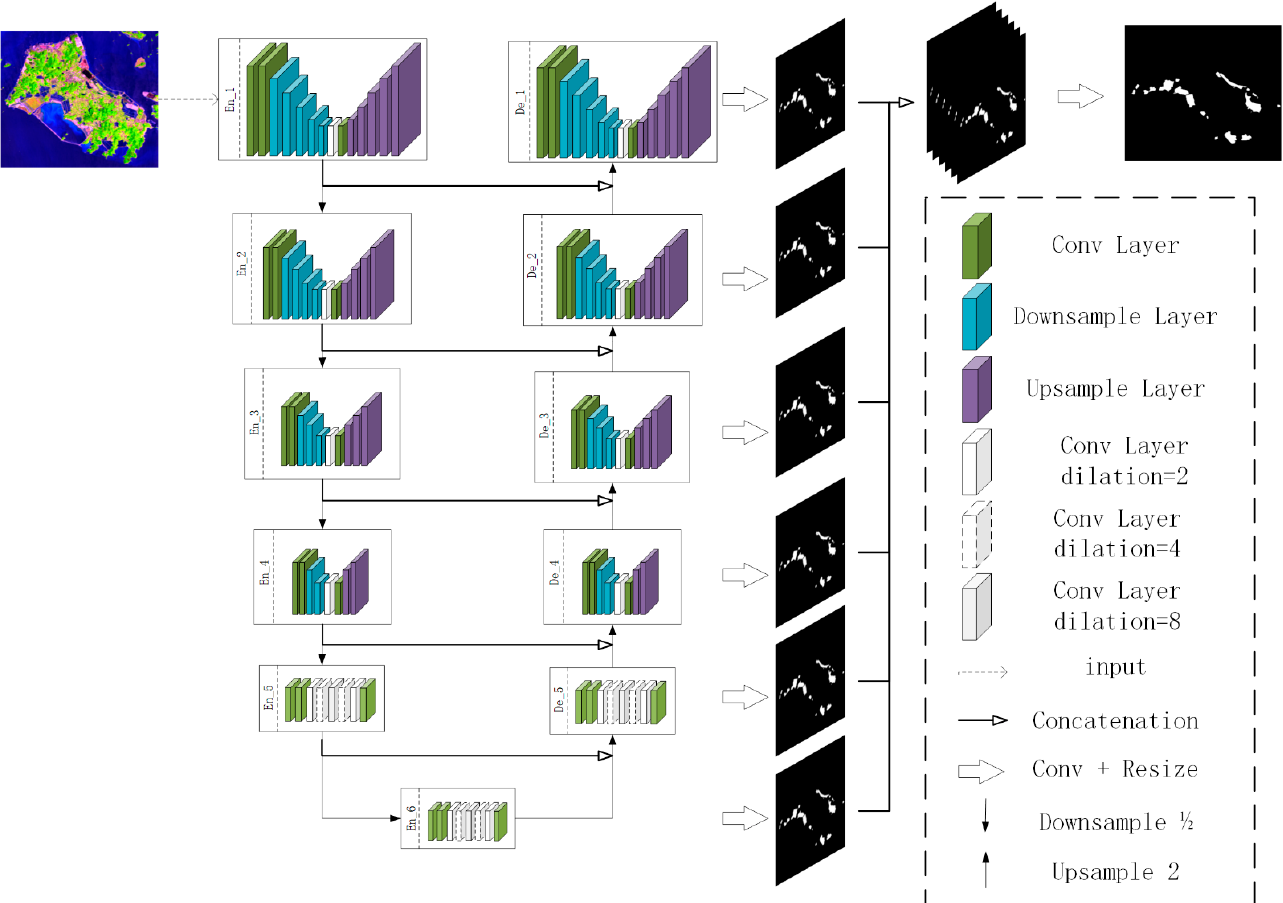
Figure 5. The construction of U 2 -Net [69].